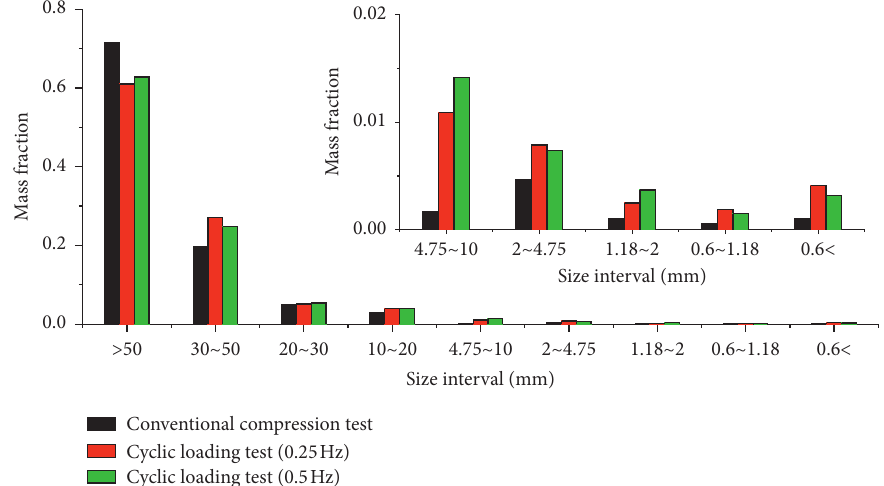
Figure 9: Mass fraction of limestone specimen fragments in different size intervals obtained under different test